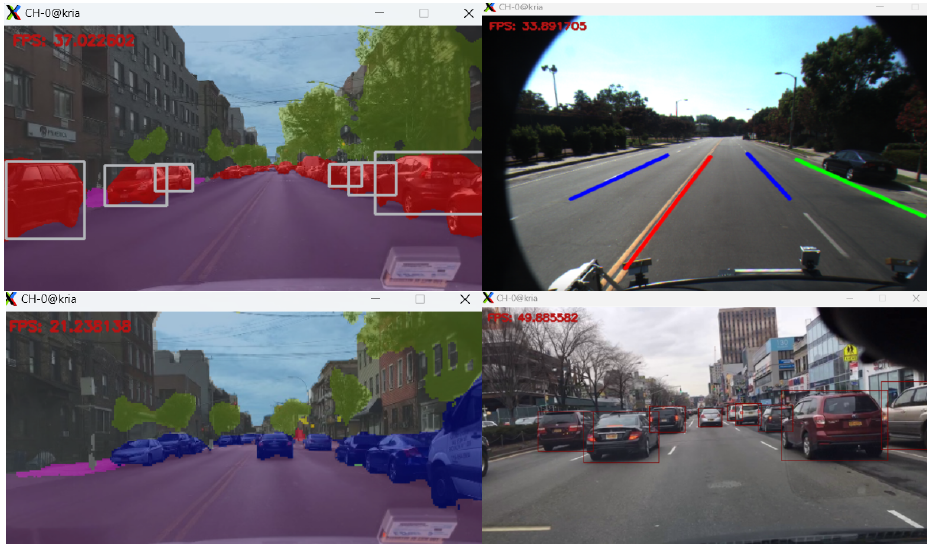
Figure 5. Lane detection and semantic